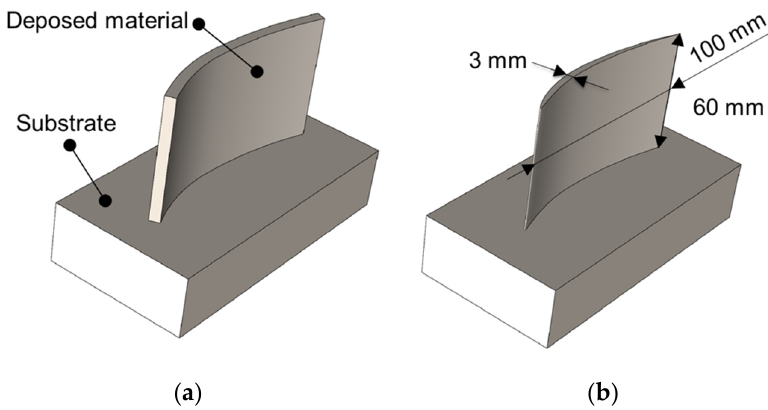
Figure 1. The selected test case after the deposition ( a ) and the milling process ( b ).